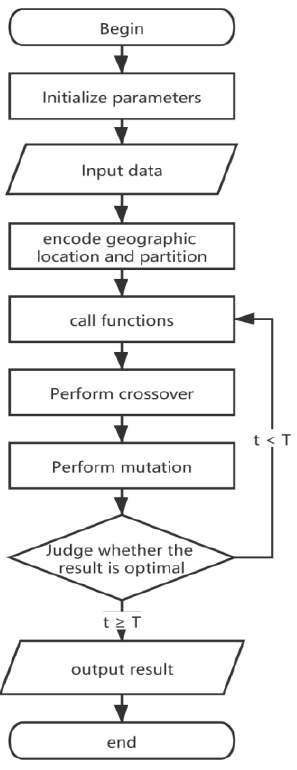
Figure 4. Algorithm 1 Flowchart.